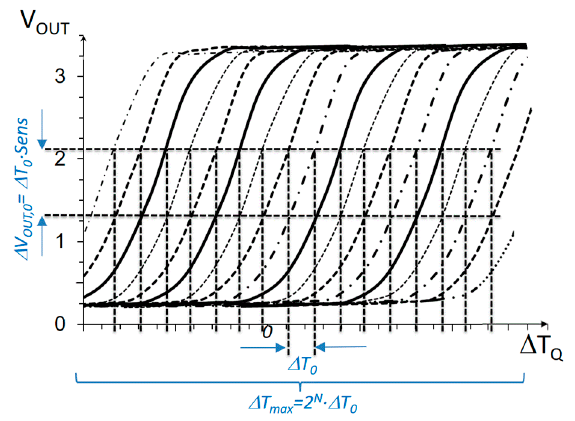
Figure 7. Characteristic curve of a differential temperature sensor with extended dynamic range and improved resolution (smaller Δ T 0 ) .